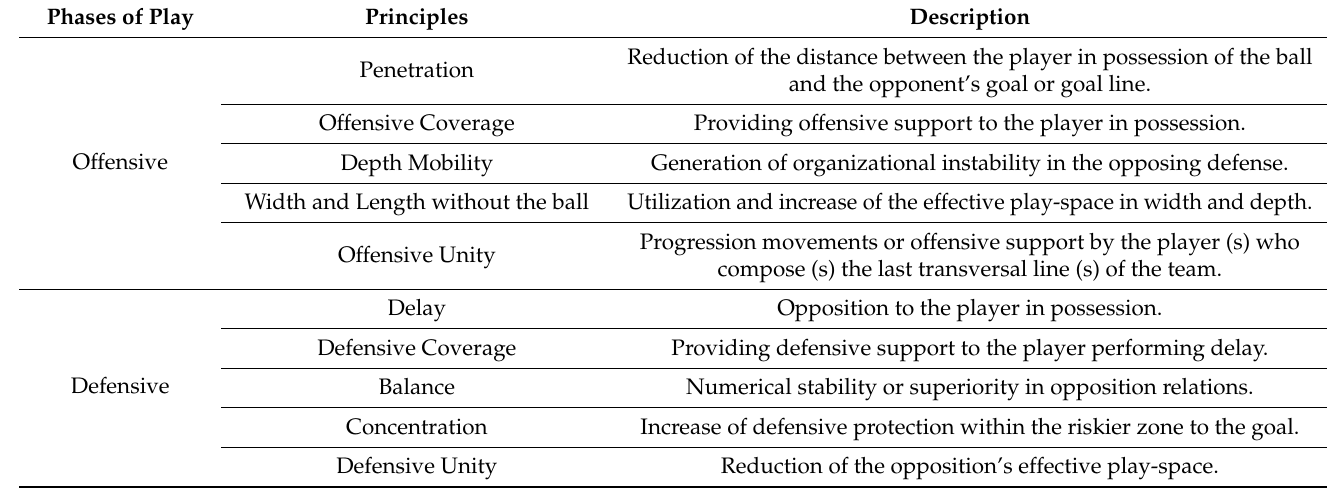
Table 1. Description of the core tactical principles of soccer 1 . Phases of